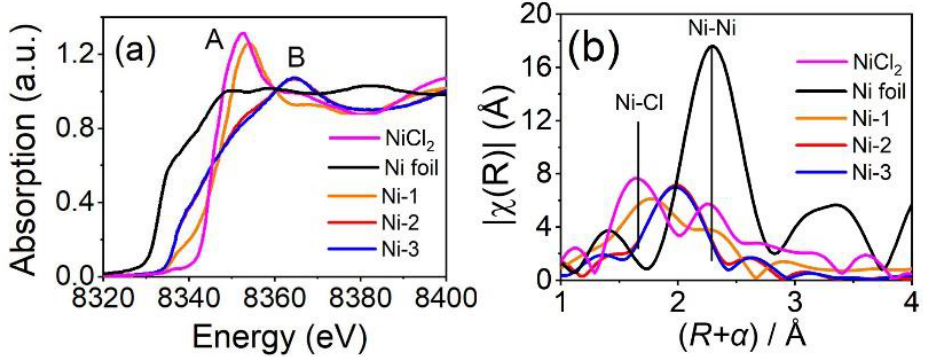
Figure 9. ( a ) Normalized XANES spectra of Ni K-edge and ( b ) Fourier-transformed extended X-ray absorption fine structure (EXAFS) of the Al-LMP-2%NiCl 2 ball-milled samples for 1–3 h together with NiCl 2 and Ni foil.